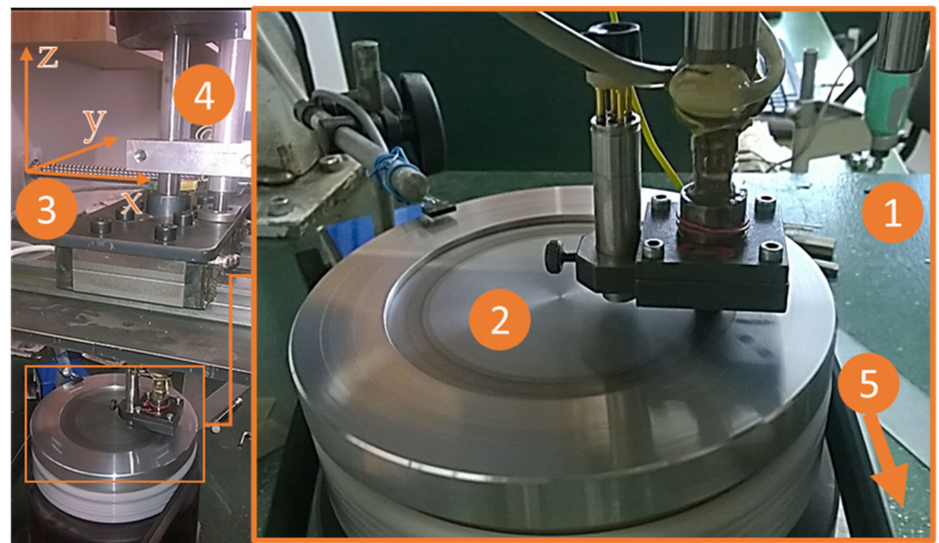
Figure 4. Main units of the pin-on-disc test system.